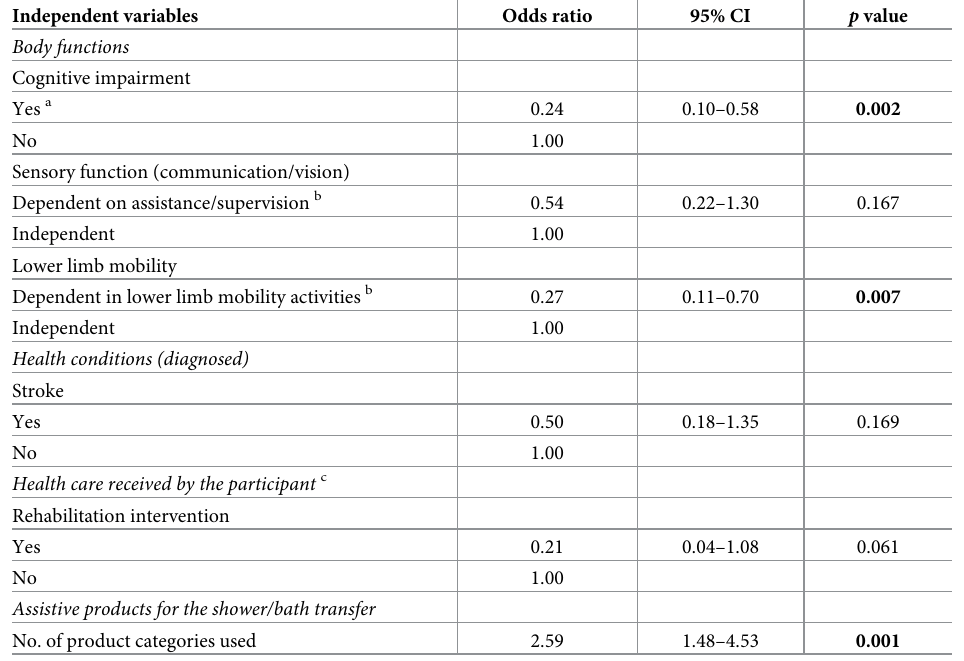
Table 3. Multivariate logistic regression predicting independence functional in the performance of the transfer to the shower/bath ( n =